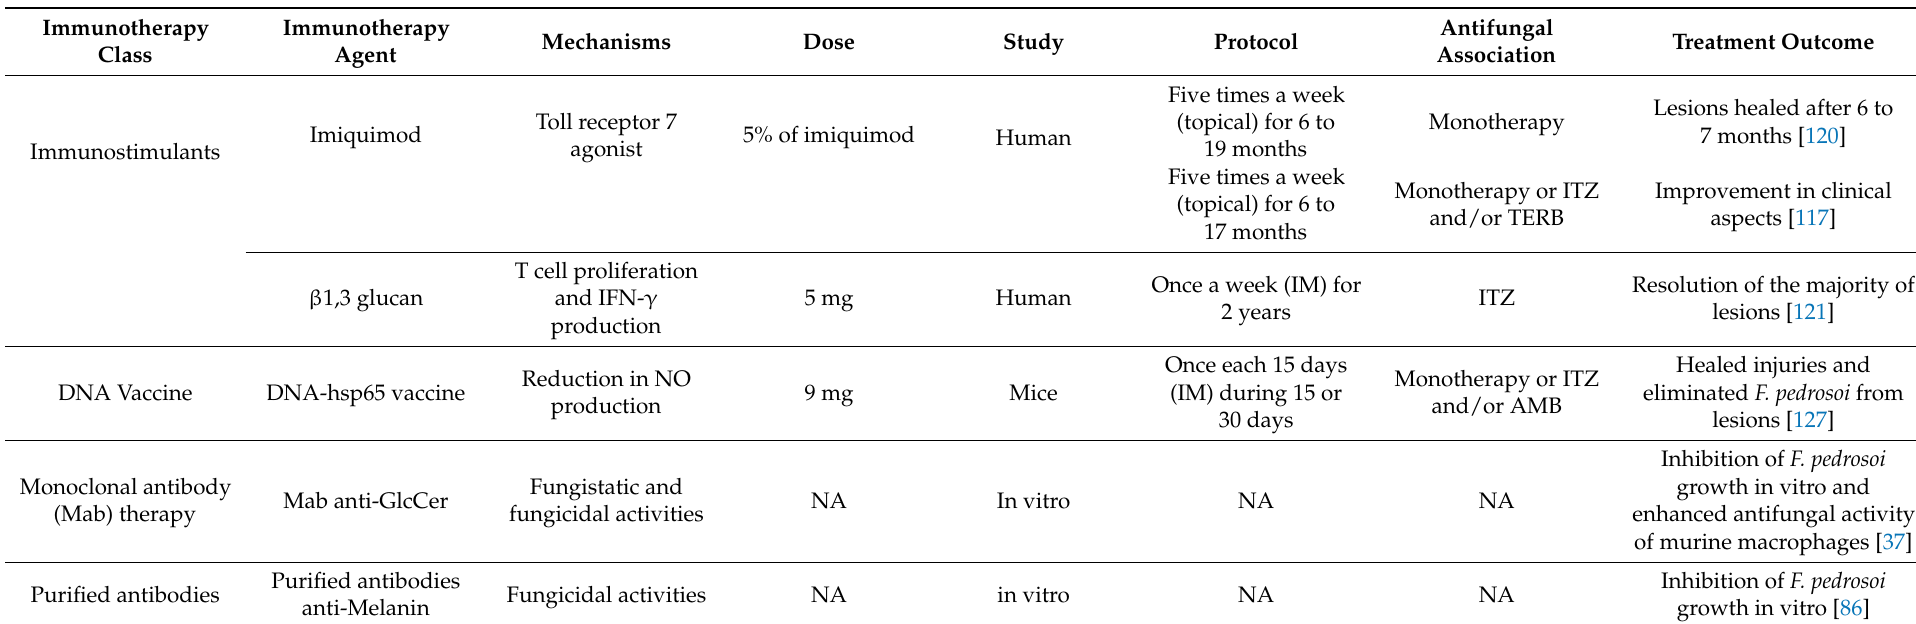
Table 1. Features of the reported chromoblastomycosis immunotherapeutic